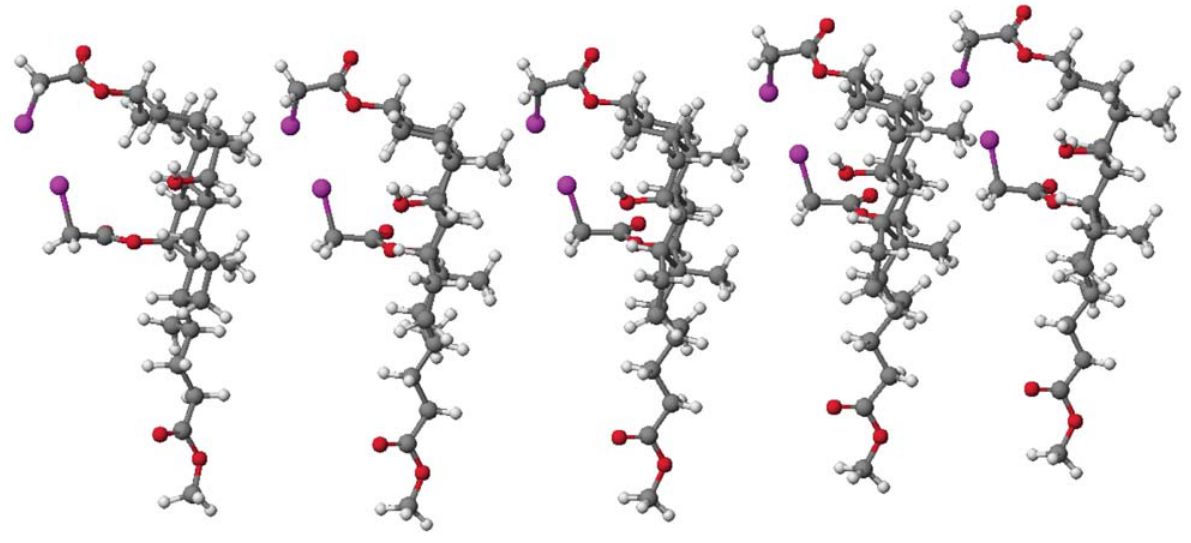
Figure 2. Molecular models of compound 8 calculated by PM5